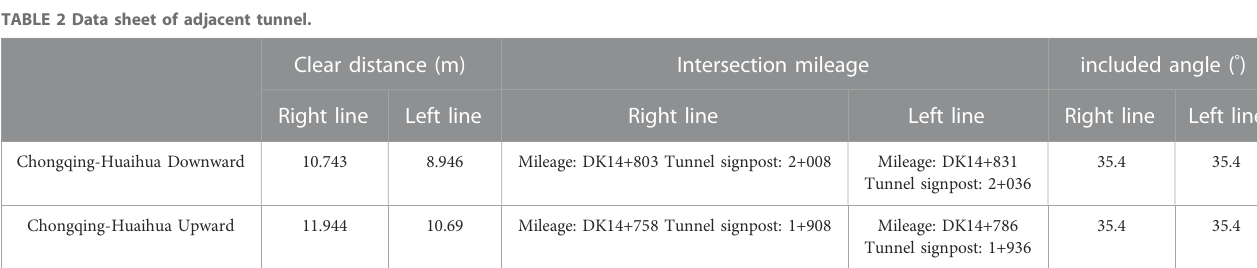
TABLE 2 Data sheet of adjacent tunnel.